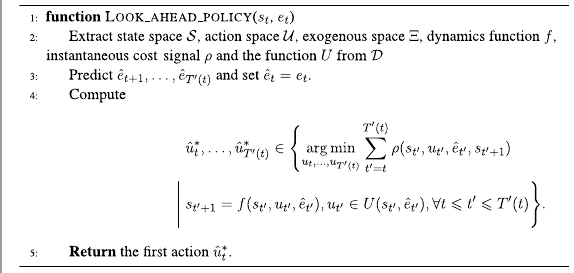
Algorithm1. Look-aheadpolicyfordecisionprocess D andpolicyhorizon K .